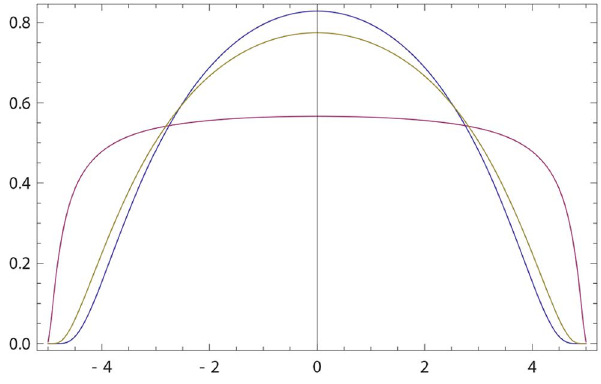
Figure 2. Opinions described via bump densities (28). Blue curve: the initial opinion of P given by (28) with b = 1. Purple curve: the opinion of Q described by (28) with b ~ 0 : 001 . Olive curve: the resulting opinion of P obtained via (16) with E ~ 0 : 5 .